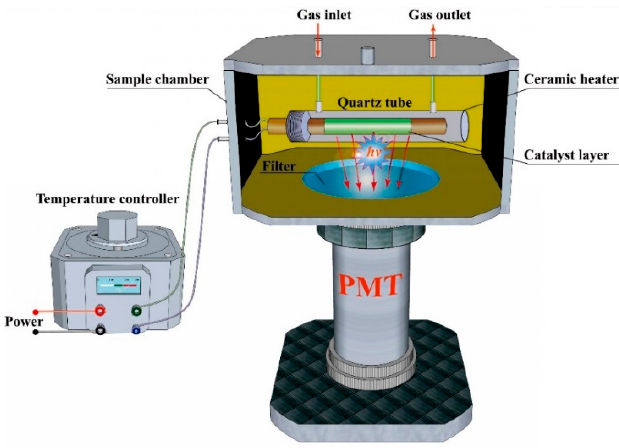
Figure 9. Schematic diagram of CTL-based sensor.